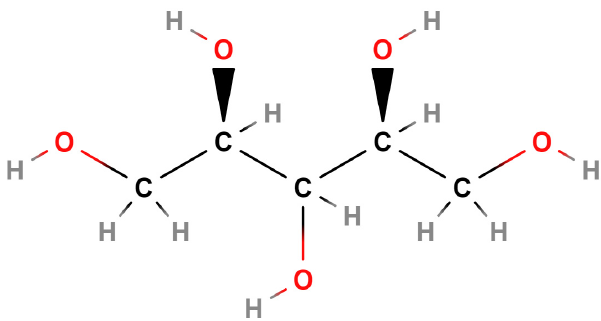
Figure 15. A representative structure of XOs (C 5 H 12 O 5 ) n.